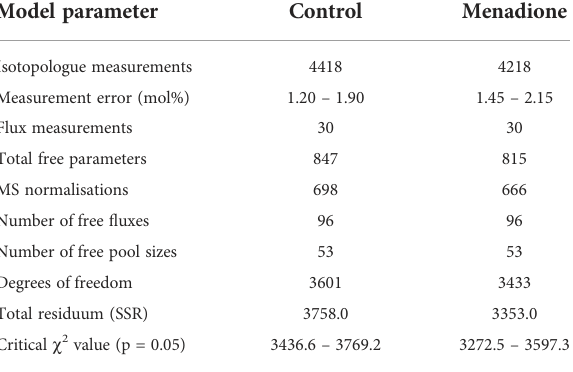
TABLE 1 Summary of characteristics of best- fi t fl ux models for control cells and cells treated with 60 µM menadione. Model